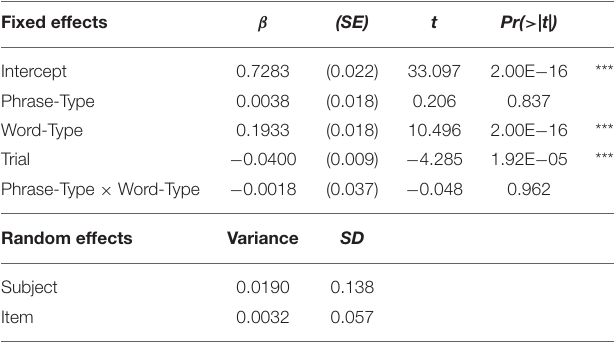
TABLE 2 | L2 form accuracy LMER